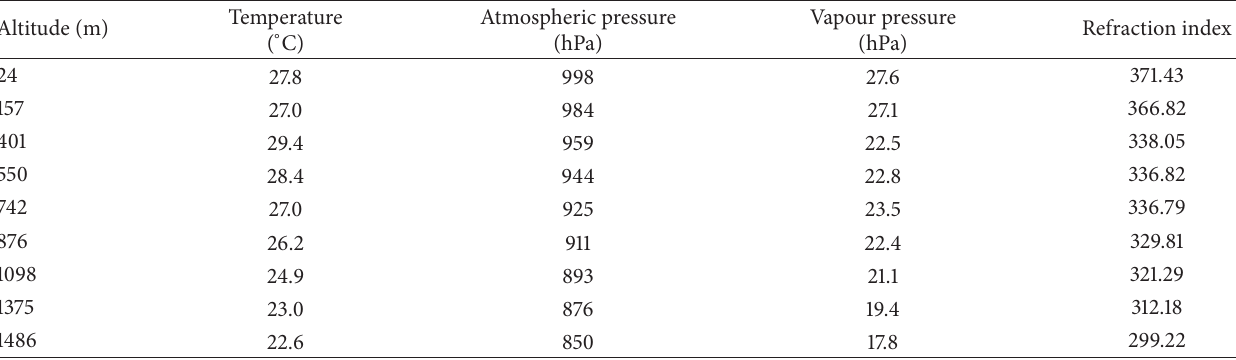
Table 3: Sounding data for the Haikou area at 8:00, August 2, 2014.